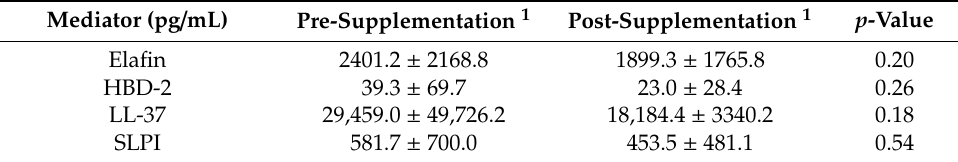
Table 3. Antiviral protein levels in cervicovaginal fluid pre- and post-vitamin D supplementation.